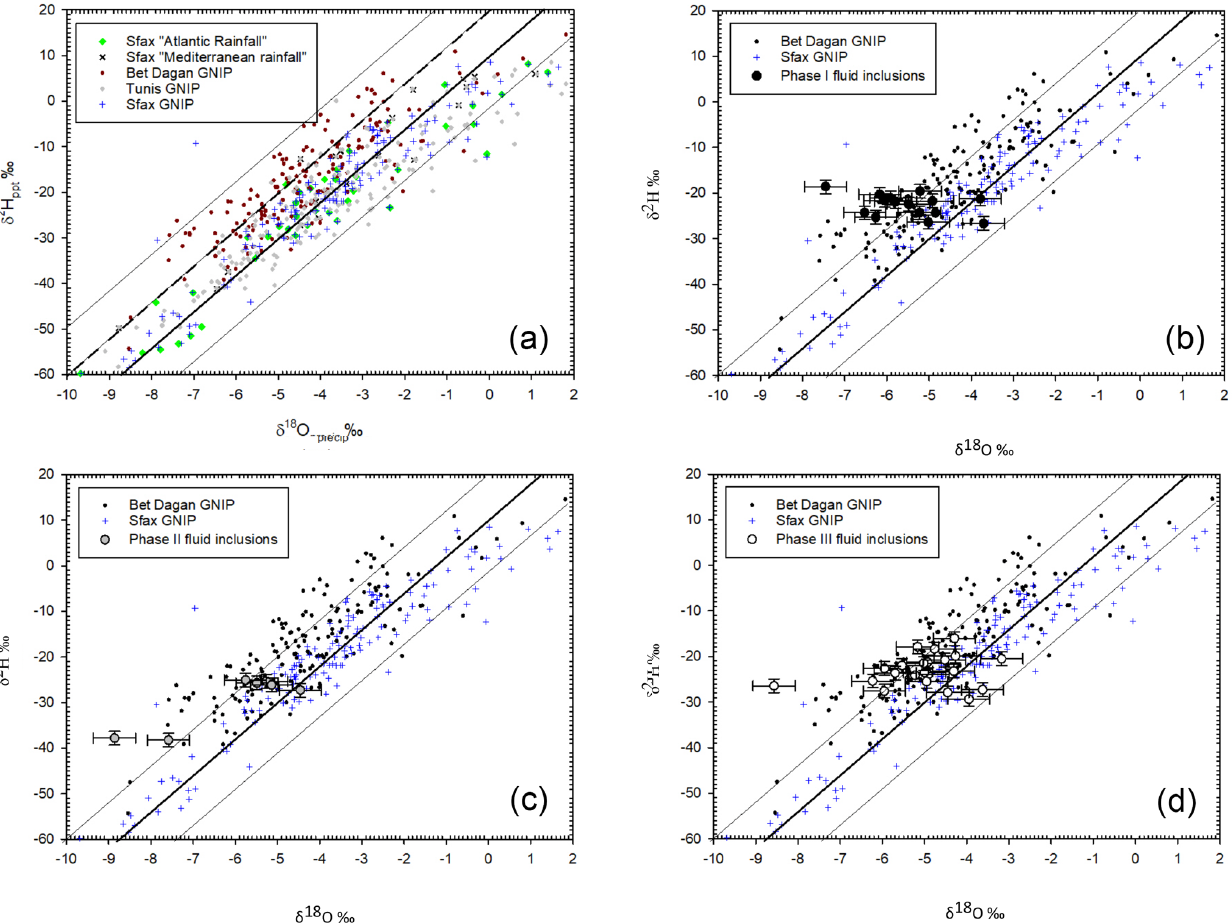
Figure 5. (a) Regional precipitation isotope data. The thick line represents global meteoric water line, the dashed thick line the Mediterranean meteoric water line and thin lines the expected range of deviation ( ± 10‰ δ 2 H ppt ) below GMWL and above MMWL. Bet Dagan, Tunis and Sfax GNIP datasets (http://www-naweb.iaea.org/napc/ih/IHS_resources_gnip.html, last access: 16 August 2016). Sfax Atlantic and Mediterranean rainfall are taken from Celle-Jeanton et al. (2001). (b–d) Summarised precipitation isotopes and fluid inclusion measurements for SC-06-01 for Phases I, II and III